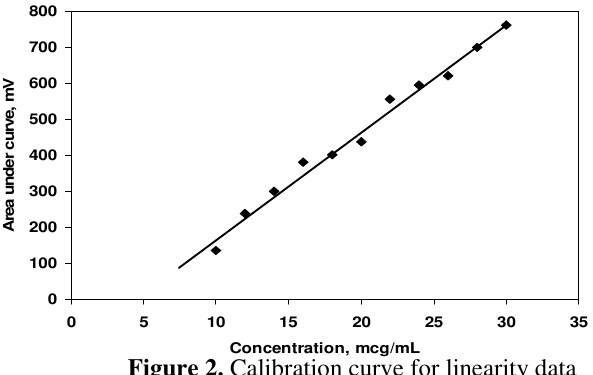
Figure 2. Calibration curve for linearity